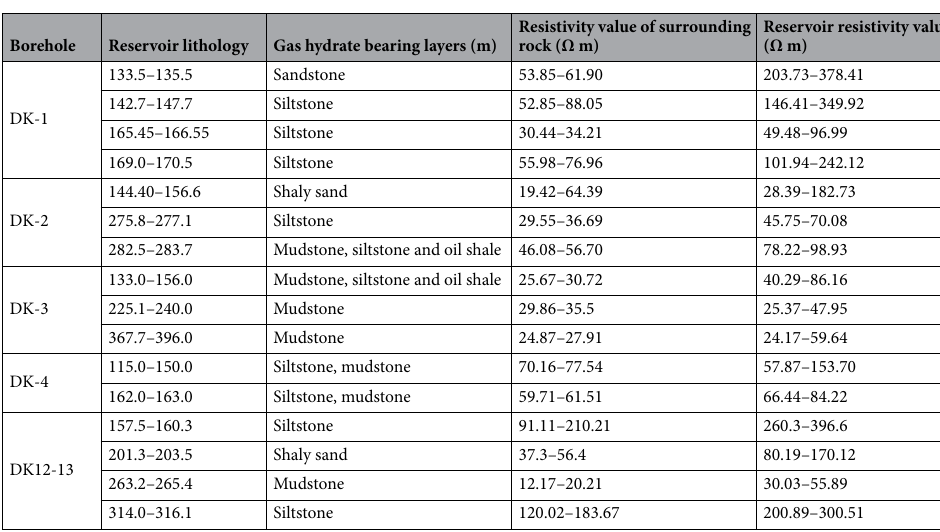
Table 1. Statistics of resistivity values of NGH Reservoirs from resistivity